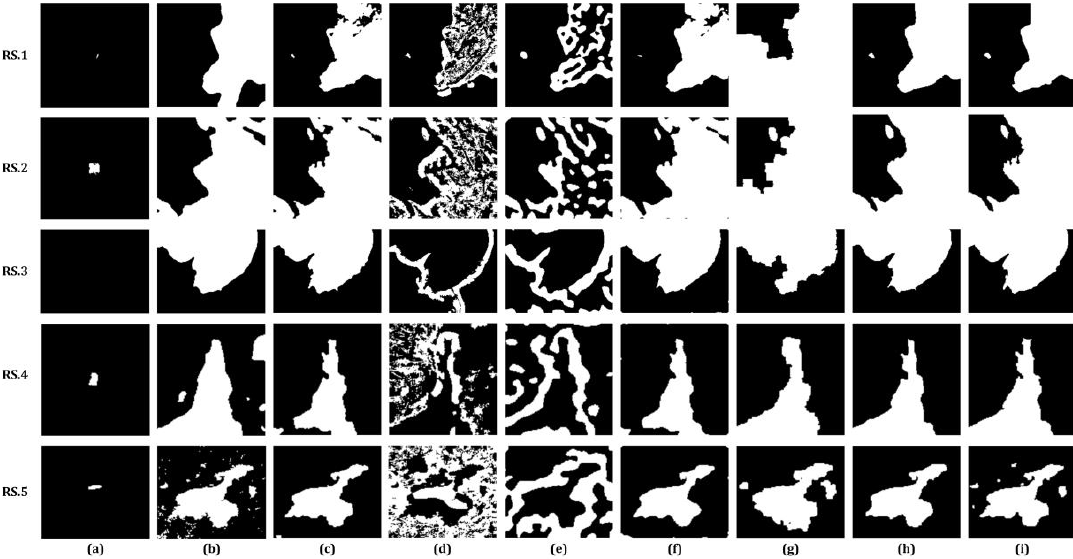
Figure 12. Binary segmentation results of remote sensing image database: ( a ) GAC; ( b ) CV; ( c ) SBGFRLS; ( d ) LBF; ( e ) ILFE; ( f ) Cao’s model; ( g ) MSRM; ( h ) the proposed method; ( i ) ground truth. Table 2. Statistic for F values, and bold values indicate the top two results.